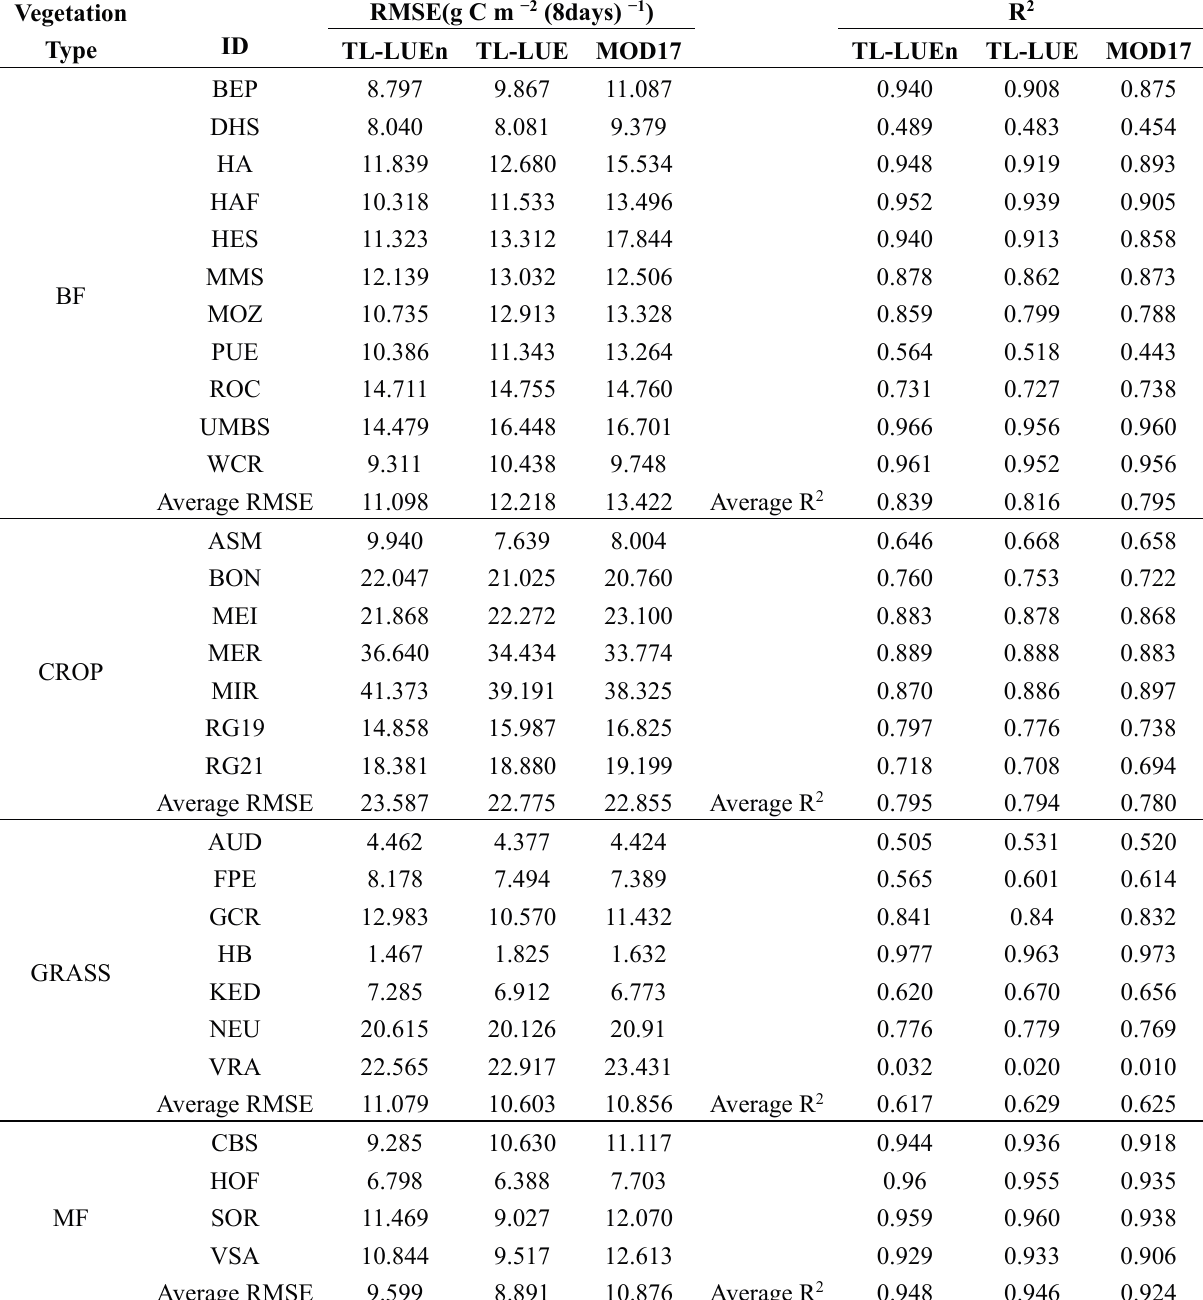
Table A3. Assessment of 8-day GPP simulated using TL-LUEn, TL-LUE and MOD17 for the 58 evaluation